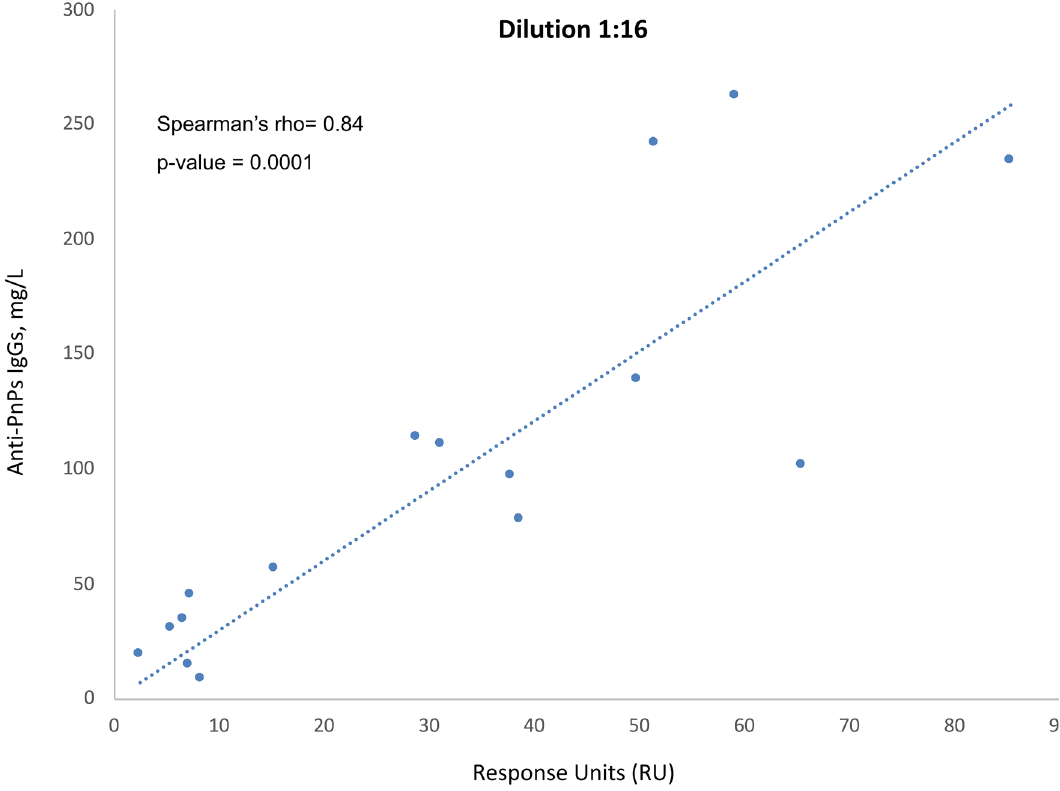
Figure 5. Correlation between SPR response and serum anti-PnPs IgGs levels determined by ELISA. Spearman’s rank correlation analysis between SPR response (RU) and serum anti-PnPs IgGs levels determined by ELISA (mg/L) for all samples included in the study with a serum anti-PnPs IgGs concentration below 270 mg/L, as determined by ELISA (SPR results for the 1:16 dilution).